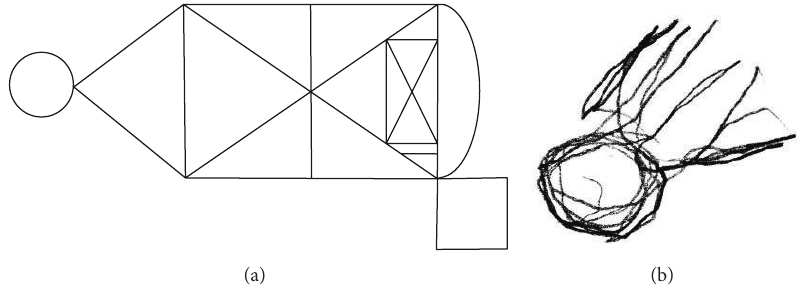
Figure 2: Copy of the semicomplex figure (model on the left; patient’s copy on the right).